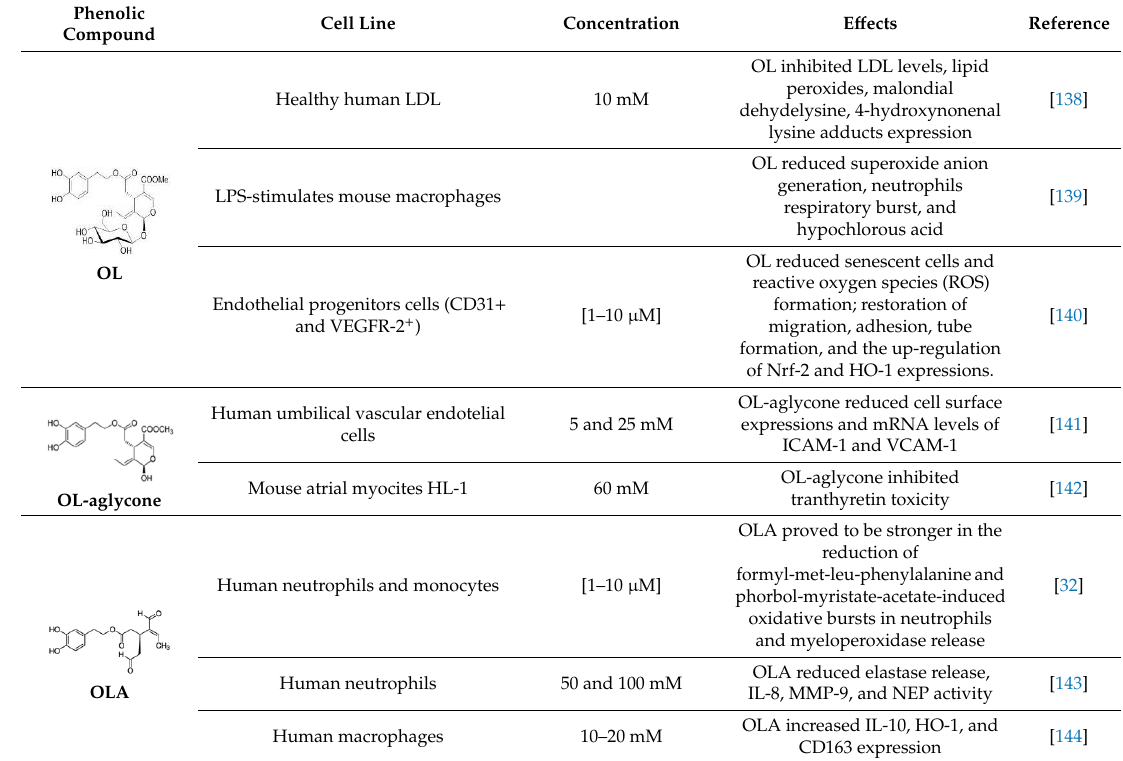
Table 4. Beneficial effects of secoiridoids from the olive tree in the control and progression of different types of cardiovascular diseases: in vivo and clinical